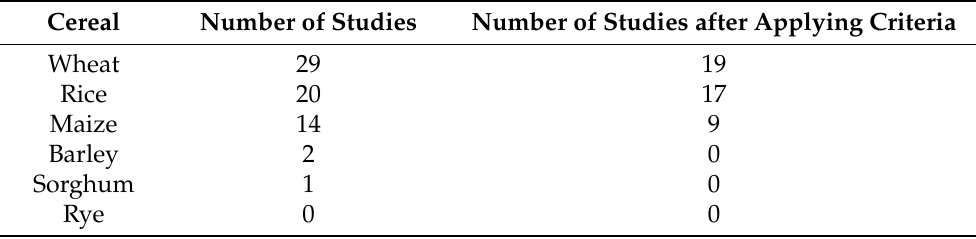
Table 10. Number of documents retrieved for each cereal crop